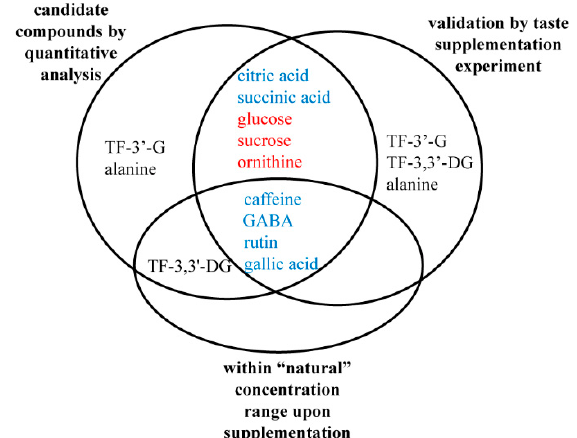
Figure 2. Venn diagram showing the stepwise screening and validation experiments of the key compounds affecting the sweet-mellow taste of the congou black tea infusions. The compounds marked in blue and red represent the compounds that were negatively and positively correlated with the sweet-mellow taste of congou black tea infusions, respectively. TF-3 ′ -G, theaflavin-3 ′ -gallate; TF-3,3 ′ -DG, theaflavin-3,3 ′ -digallate; GABA, γ -aminobutyric acid.